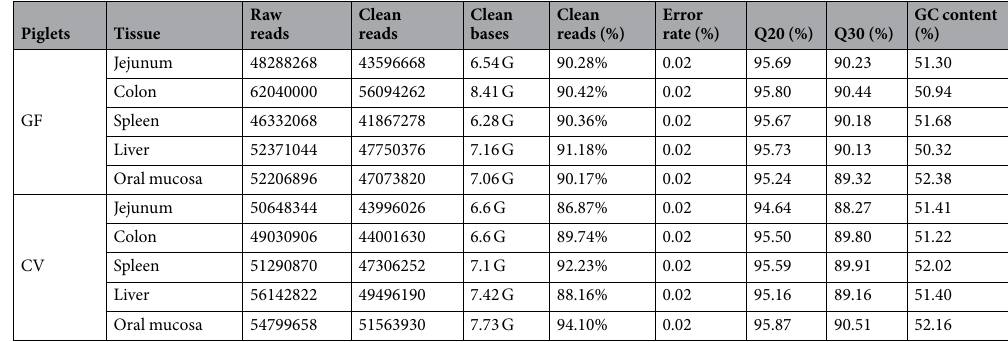
Table 1. Quality and characteristics of sequences from cesarean-derived conventional (CV; n = 4) and germ- free (GF; n = 4) piglets from the same litter. Q20 and Q30 represent the proportion of bases with Phred quality scores > 20 and > 30,